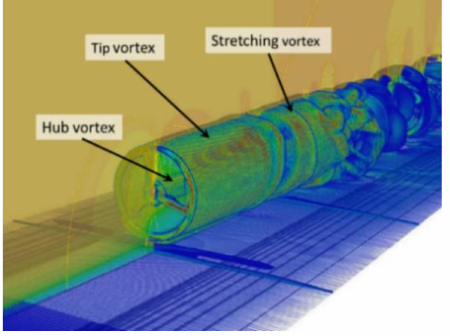
Figure 10. The vortex distribution on a wind turbine line.